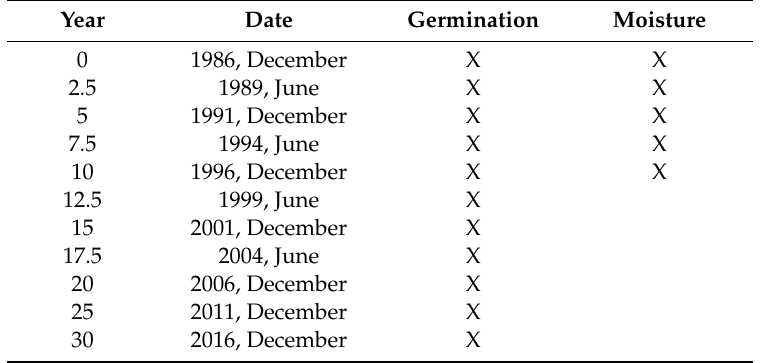
Table 4. Dates of the retrieval of the samples over the first 30 years, and types of tests conducted.